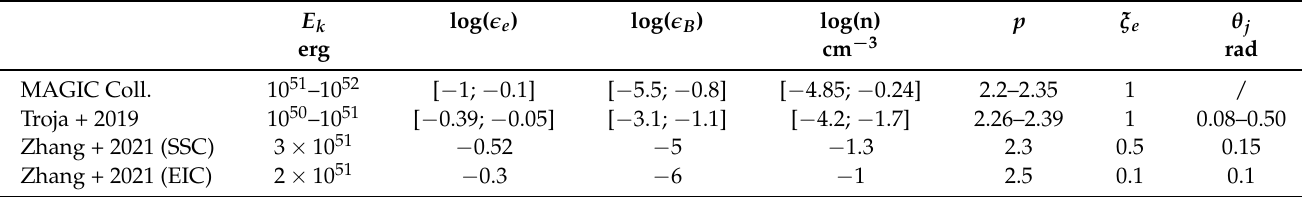
Table 1. GRB160821B. List of the best fit parameters inferred from multi-wavelength modeling of the afterglow radiation by different